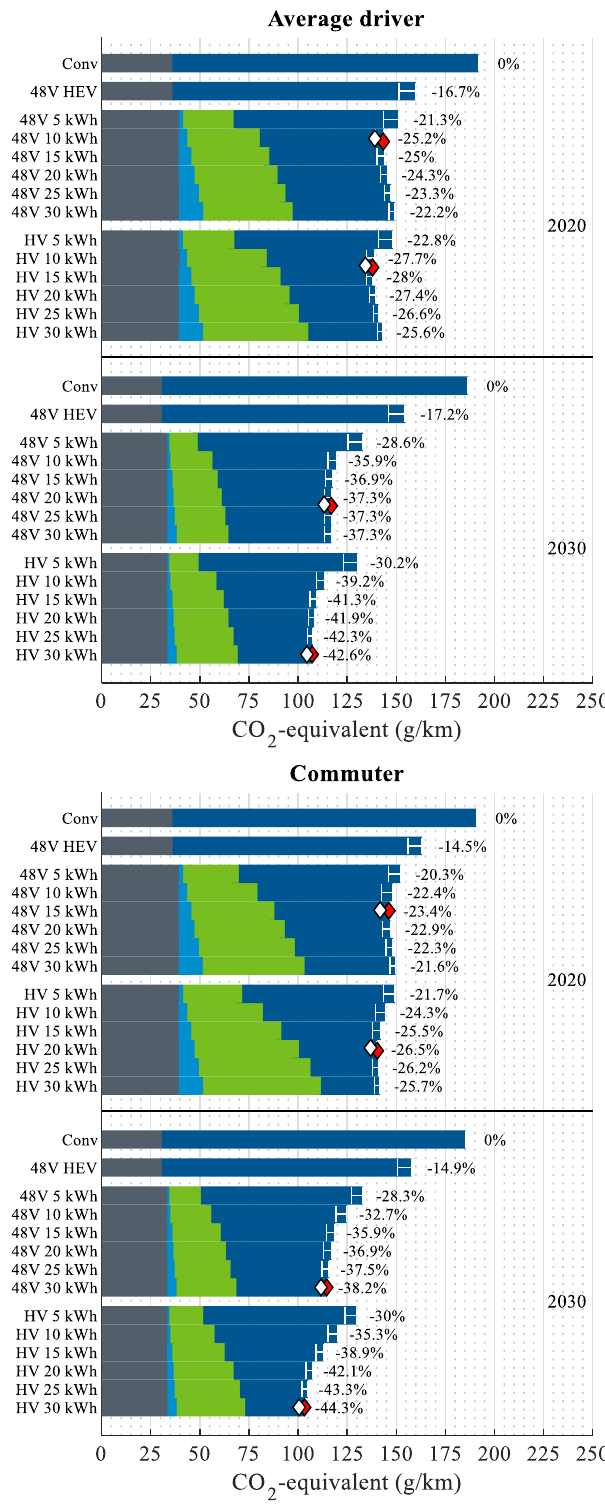
Figure 8. Use case LCA emissions for the compact vehicle and ECMS. The colors indicate the emission sources. The white error bars show EMSs optimization potentials with DP. The diamonds mark the minimum LCA systems for ECMS (red) and DP (white).